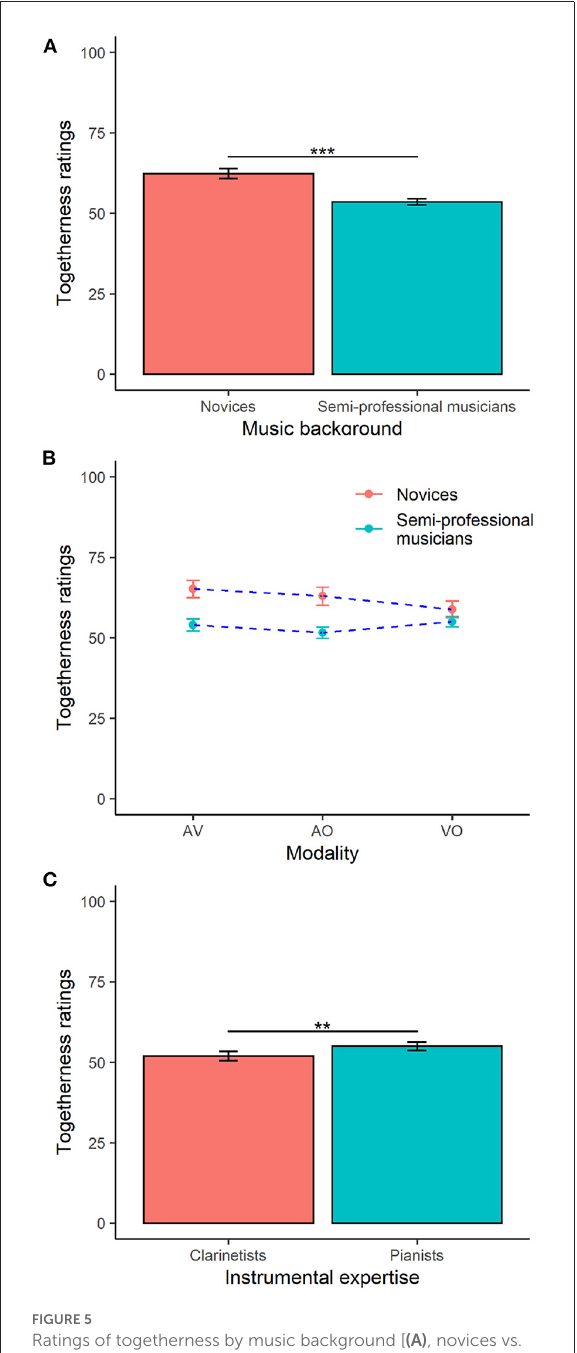
FIGURE5 Ratings of togetherness by music background [ (A) , novices vs. semi-professional musicians]; the interactions (B) between modality of stimulus presentation (audio plus video [AV], video only [VO] and audio only [AO]) and music background; and, instrumental expertise of the semi-professional musicians [ (C) , clarinetists vs. pianists]. Maximum and minimum values on the y-axis have been fixed to allow comparison between the graphs against the full range of the scale. Error bars represent 95% CI of the mean. ∗∗ p < 0.01; ∗∗∗ p <